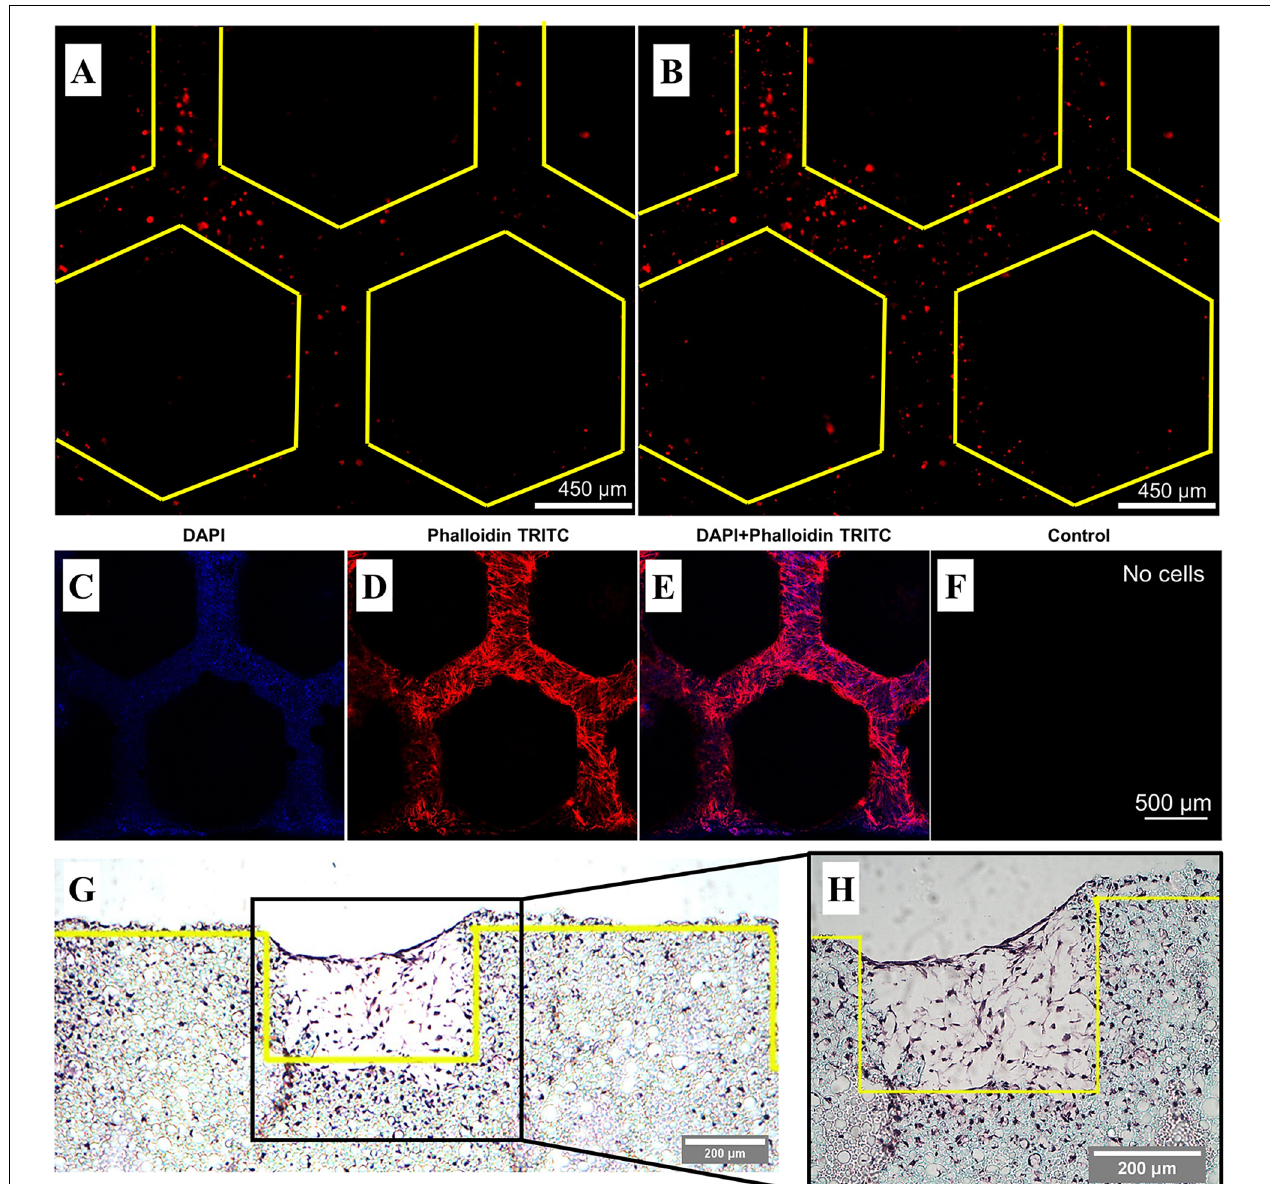
FIGURE 5 | Representative fluorescence and confocal microscopy and histological sections of hES-MPs seeded in the bone microfluidic chip in OIM with the intermittent flow profile. Yellow lines demarcate the edge of the pillars. Live CellTracker TM images on (A) day 1 and (B) day 3 taken through the PDMS chamber. (C–F) Day 14 confocal images of nuclei stained with DAPI (blue) and actin with phalloidin-TRITC (red). Individual color channels and composite shown. The control was not autofluorescent, hence it appears black. Cells are present throughout the channels and pillar walls. (G) Low magnification and (H) high magnification 8 µ m histology section stained with H&E stain. Cells can be seen throughout the channels to the height of the pillars, as well as within the interconnected porous network of the polyHIPE bulk material.